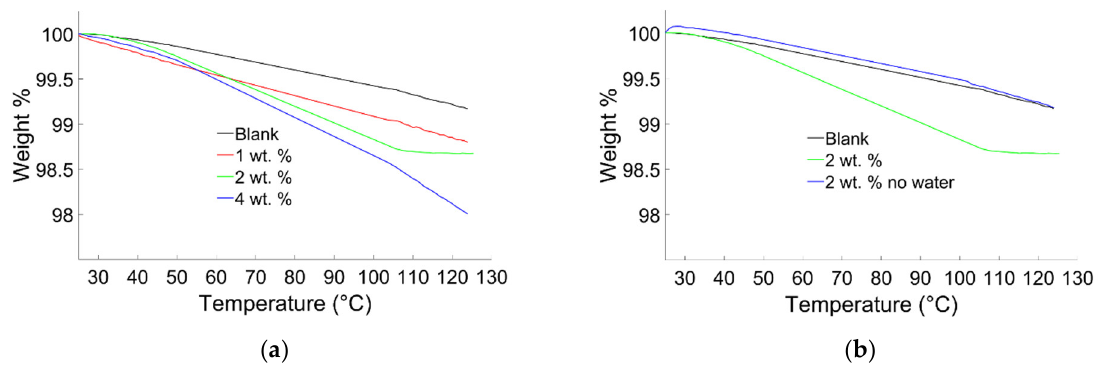
Figure 7. ( a ) Curves of TGA analysis on samples obtained using water. ( b ) Comparison between representative curves of TGA analysis carried on samples obtained with and without water.